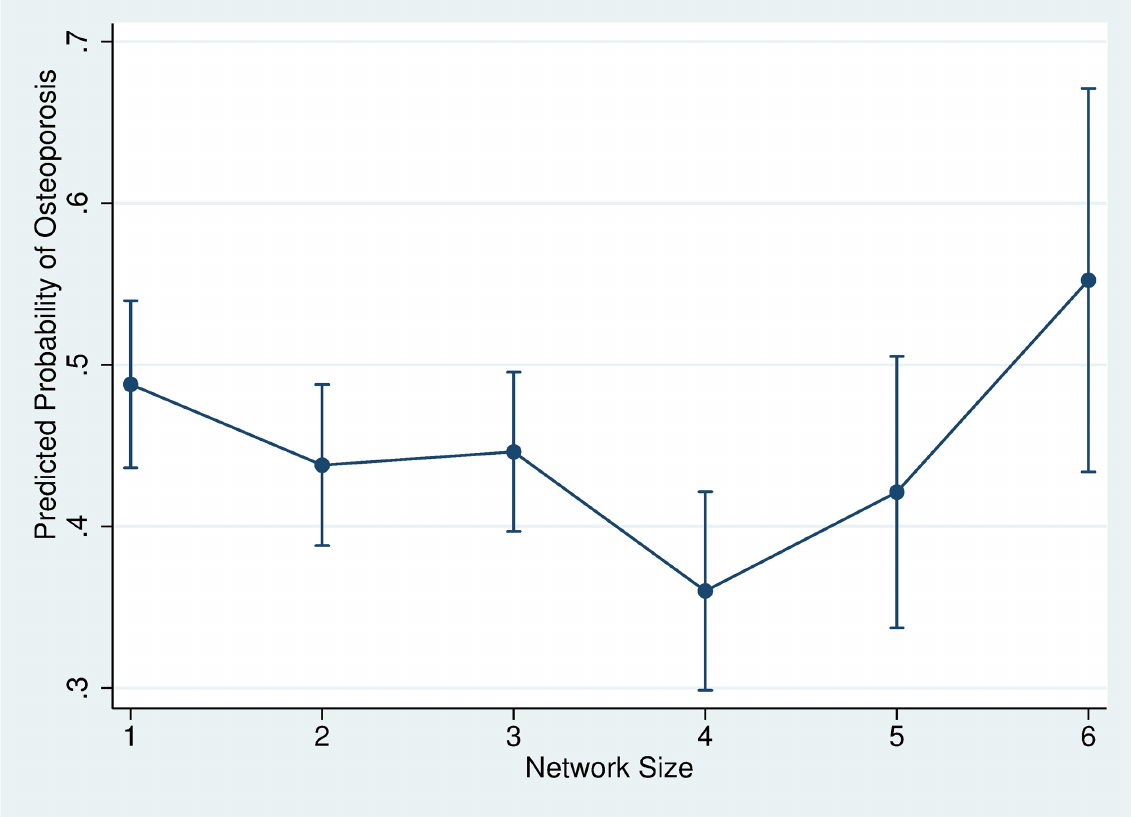
Fig 1. Probability of osteoporosis predicted by social support network size. The predictedprobabilityof having osteoporosis was calculatedfor each social support network size. The estimated predicted probabilitywas based on the logistic regression which was adjustedfor other covariatessuch as marital status, age, BMI, drinking,smoking, exercise,householdincome, educational level, livingarea, and instrumental activities of daily living. Vertical lines indicate95% confidenceintervals.